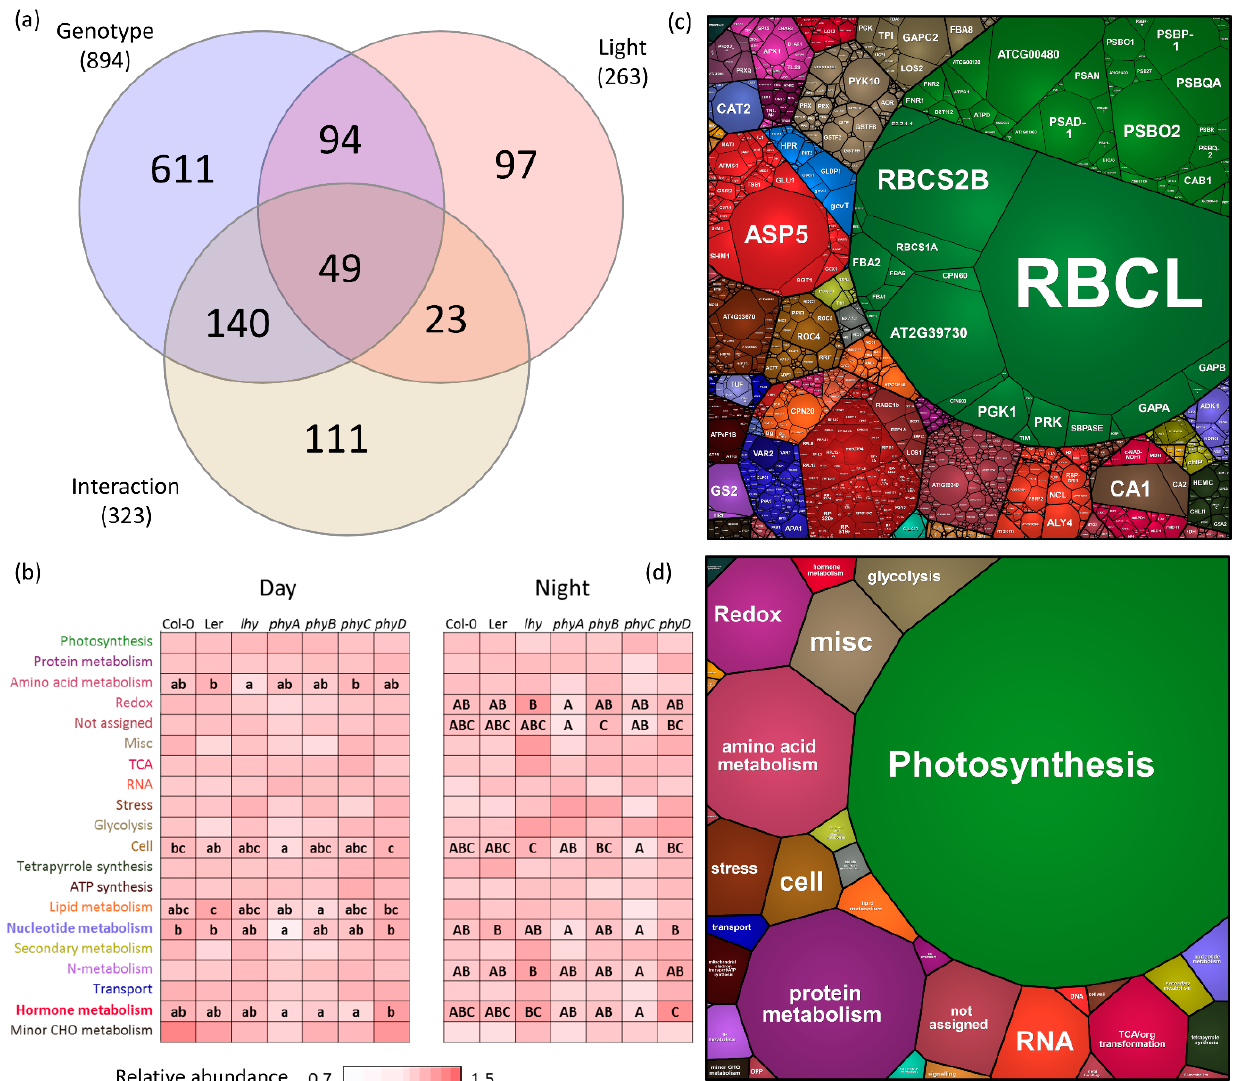
Figure 2. The proteome profile comparison of plantlets collected in the middle of the light and dark periods. ( a ) The results of the two-way ANOVA analysis based on 2587 quantified proteins and visualized in a Venn diagram; ( b – d ) Visualization of the seedling proteome in the ProteoMap; ( b ) Differences in the twenty most abundant categories visualized on a heat map and two levels of the ProteoMap ( c , d ). The ProteoMap visualization corresponds to the estimated content in Col-0 collected in the middle of the light period. The letters represent significant differences ( p < 0.05, ANOVA, Tukey’s HSD). For details, see Supplementary Table S1.